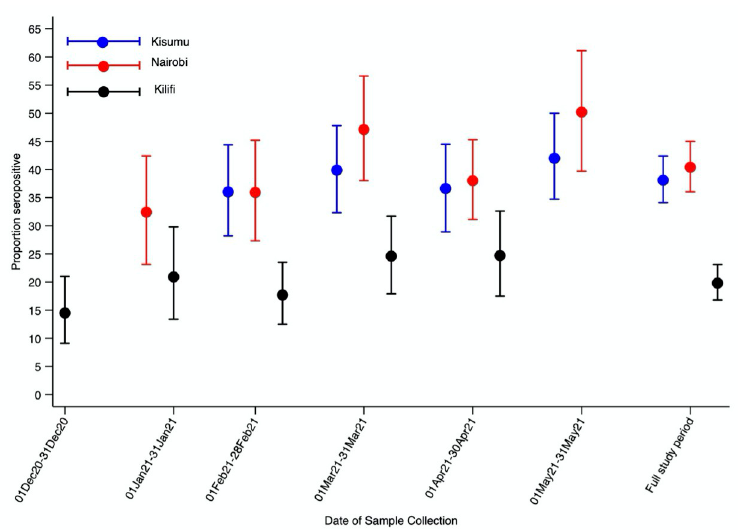
Fig 2. Seroprevalence by HDSS site and study period. Seroprevalence estimates were obtained using Bayesian threshold analysis adjusted for test performance and underlying population structure using multilevel regression and poststratification Error bars indicate 95% Credible Intervals.